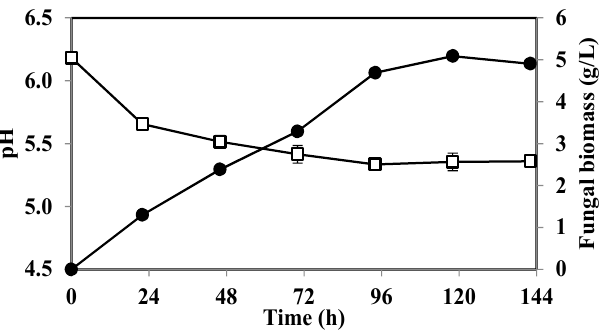
Figure 1. The effect of pH on fat degradation and glycerol release by A. oryzae in cream.